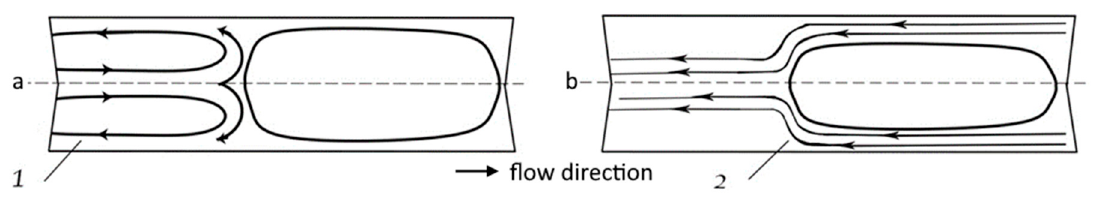
Figure 1. Two variants of the slug flow regime, called circulation and bypass: а —circulating flow; b—bypass flow; streamlines of the liquid: 1—in circulation; 2—in bypass modes.